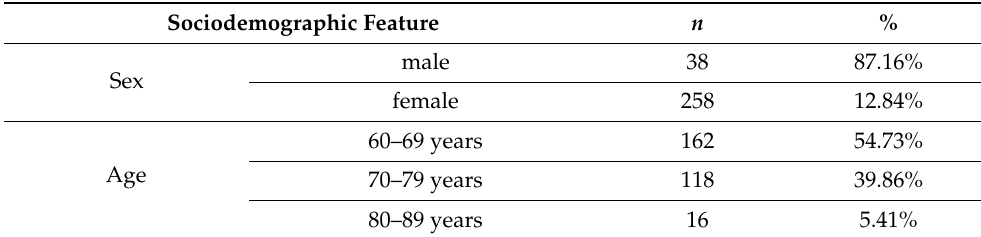
Table 1. Sociodemographic characteristics of the